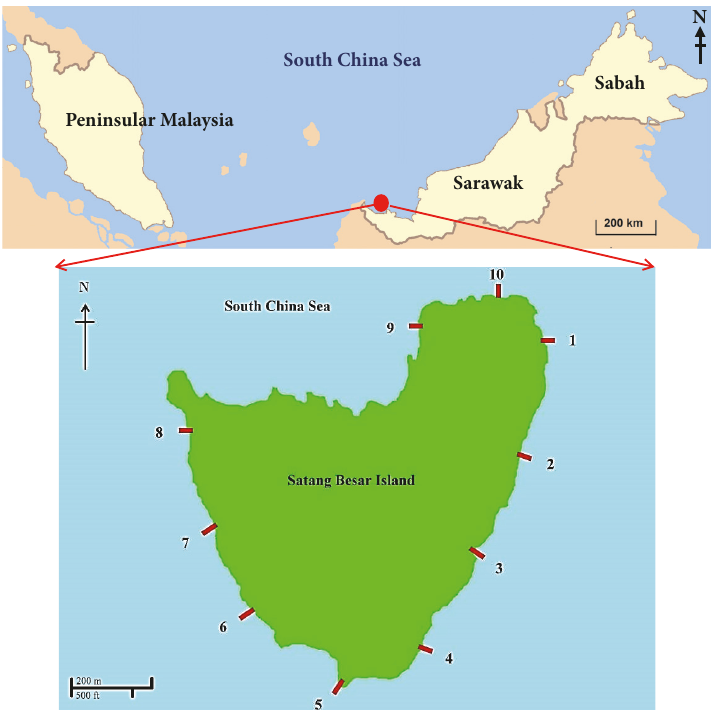
Figure 1: A map of Malaysia showing the location of Sarawak and the 10 sampling sites of Satang Besar Island.